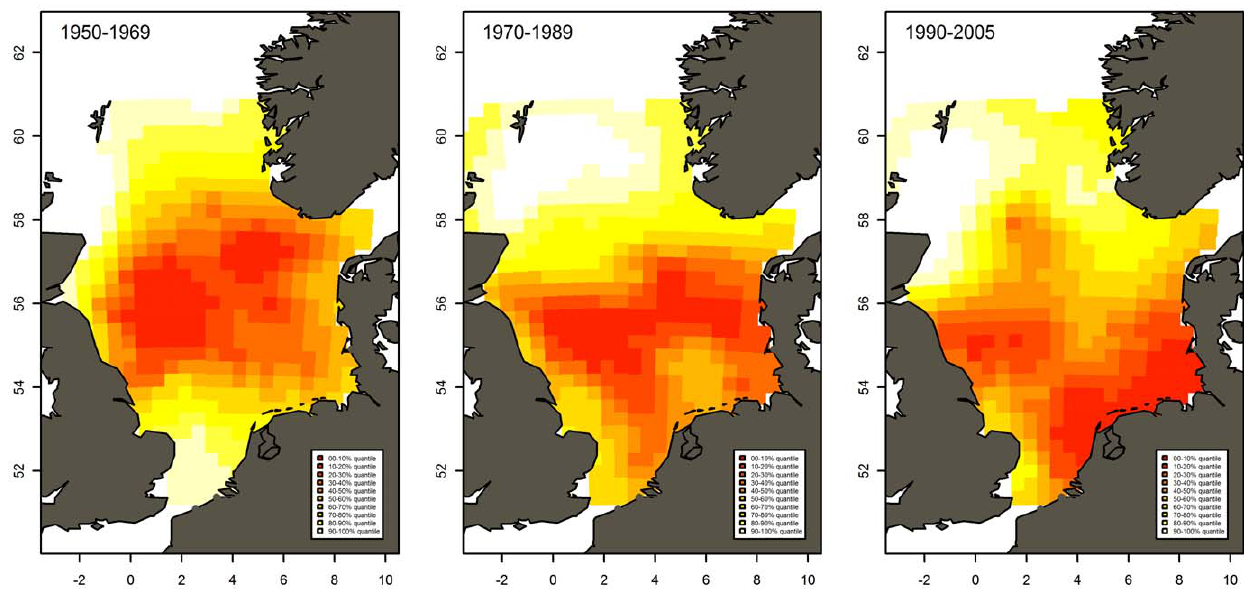
Figure 8. Modeled spatial distribution of mackerel larvae caught by CPR. Color scale from white (low abundance) represents values in 0– 10% quantile, etc. up to red 90–100% quantile (high abundance).